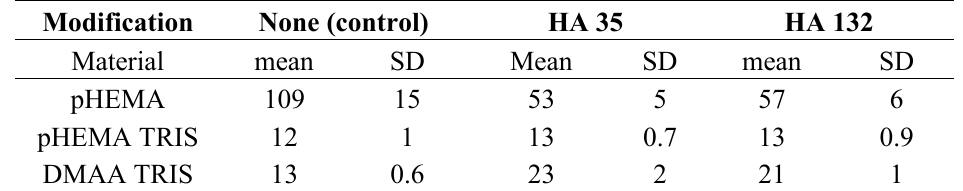
Table 2. Total mass (µg) of dexamethasone phosphate released from all model lens